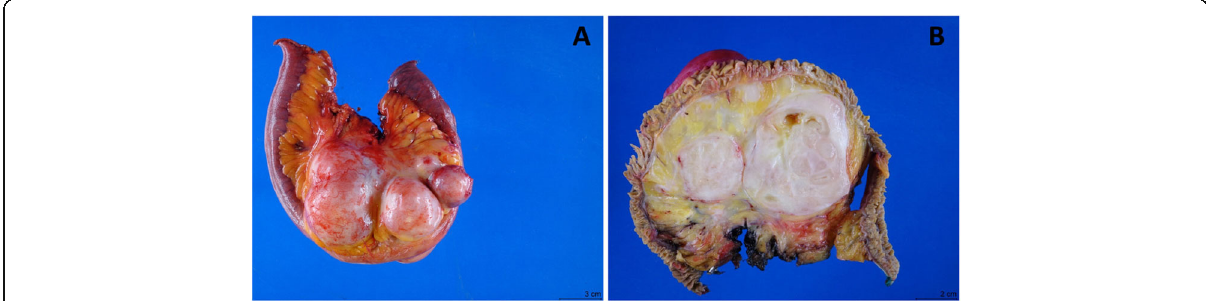
Fig. 2 Small intestine mesenteric mass had lobulated outer surface ( a ) and bulging and gelatinous cut surface with focal cystic degeneration ( b